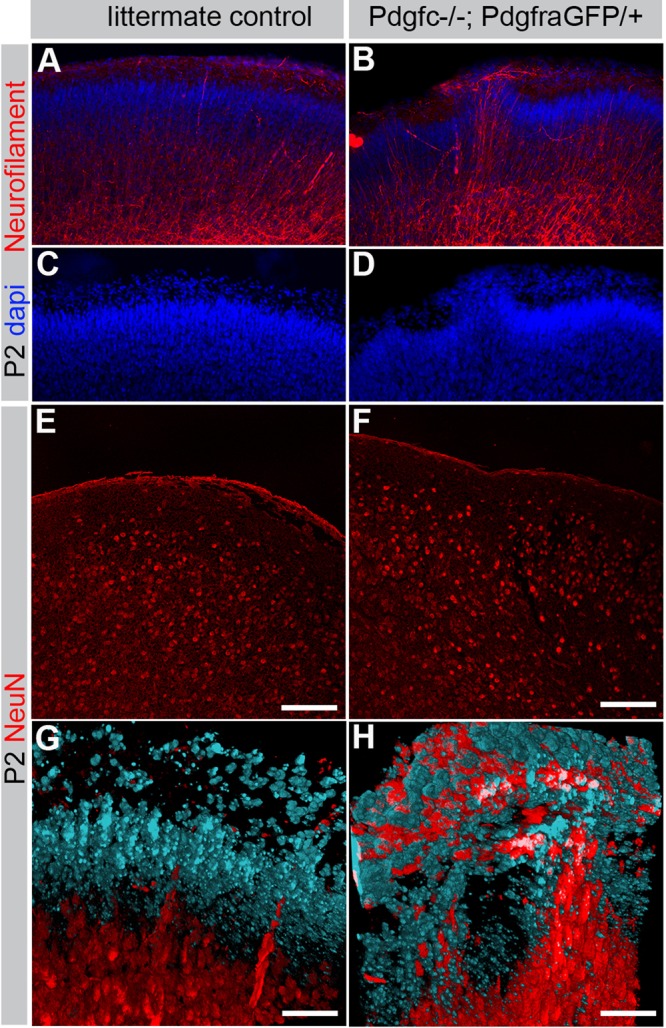
Neuronal overmigration in P2 cerebral cortex. (A,B) Immunofluorescent neurofilament staining (red) of coronal sections through the cerebral cortex visualizes neuronal overmigration in Pdgfc−/−; PdgfraGFP/+ mice. (C,D) Nuclear DAPI staining (blue) confirms displacement of the cortical cell layer in Pdgfc−/−; PdgfraGFP/+ mice. (E,F) Immunofluorescent staining of NeuN in coronal section without overmigration. (G,H) Maximum intensity projection of confocal z-stack visualizing cortical neurons with NeuN (red) and non-neuronal cells in the marginal zone with DAPI (blue). Scale bars: 100 µm in E,F; 50 µm in G,H.